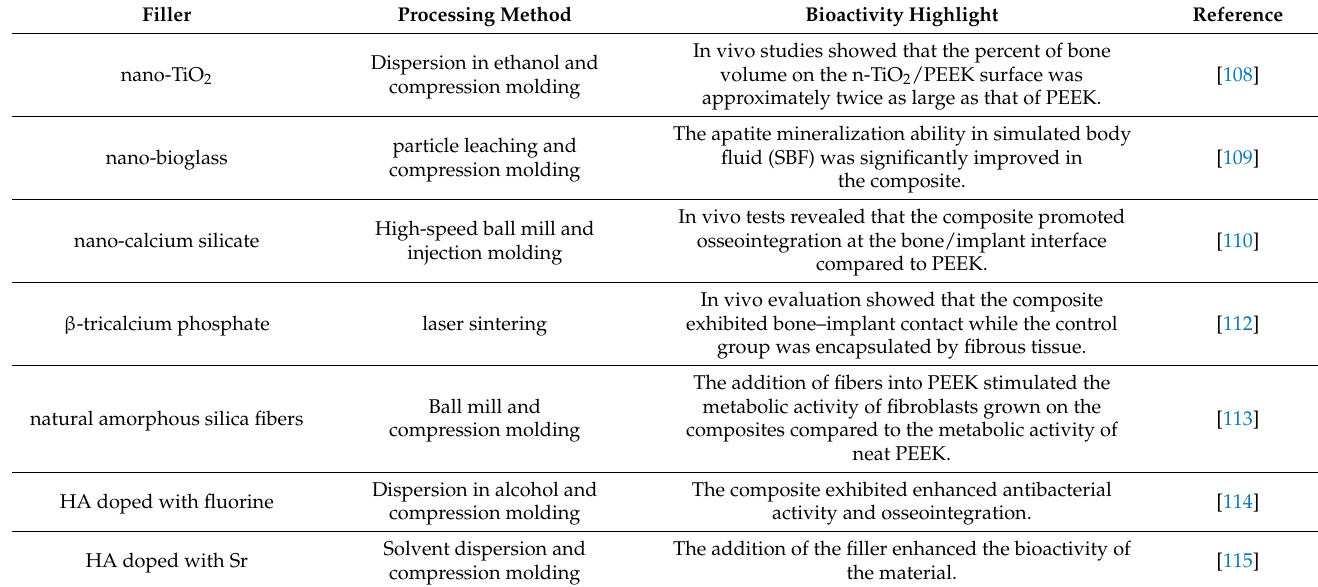
Table 3. Bioactive composites of PEEK and their processing